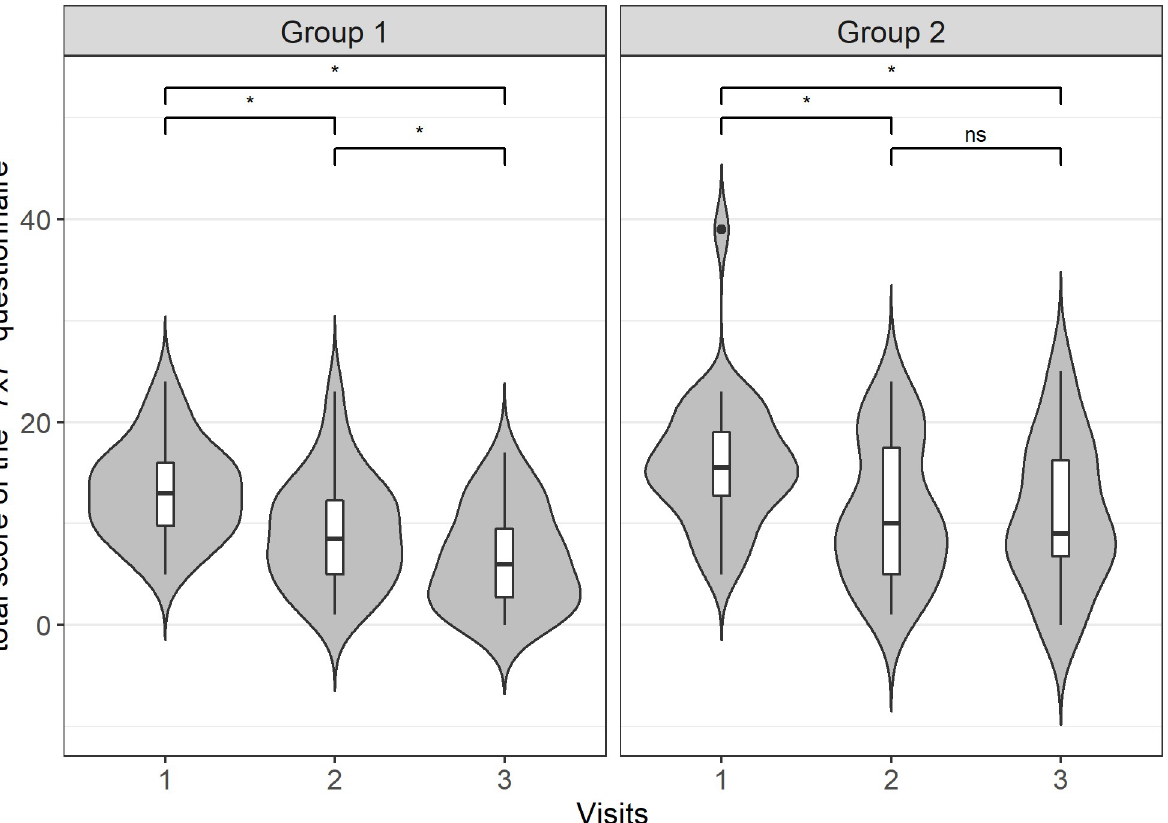
Fig 2. Total 7 × 7 questionnaire scores in group 1 and group 2 at visits 1, 2, and 3.